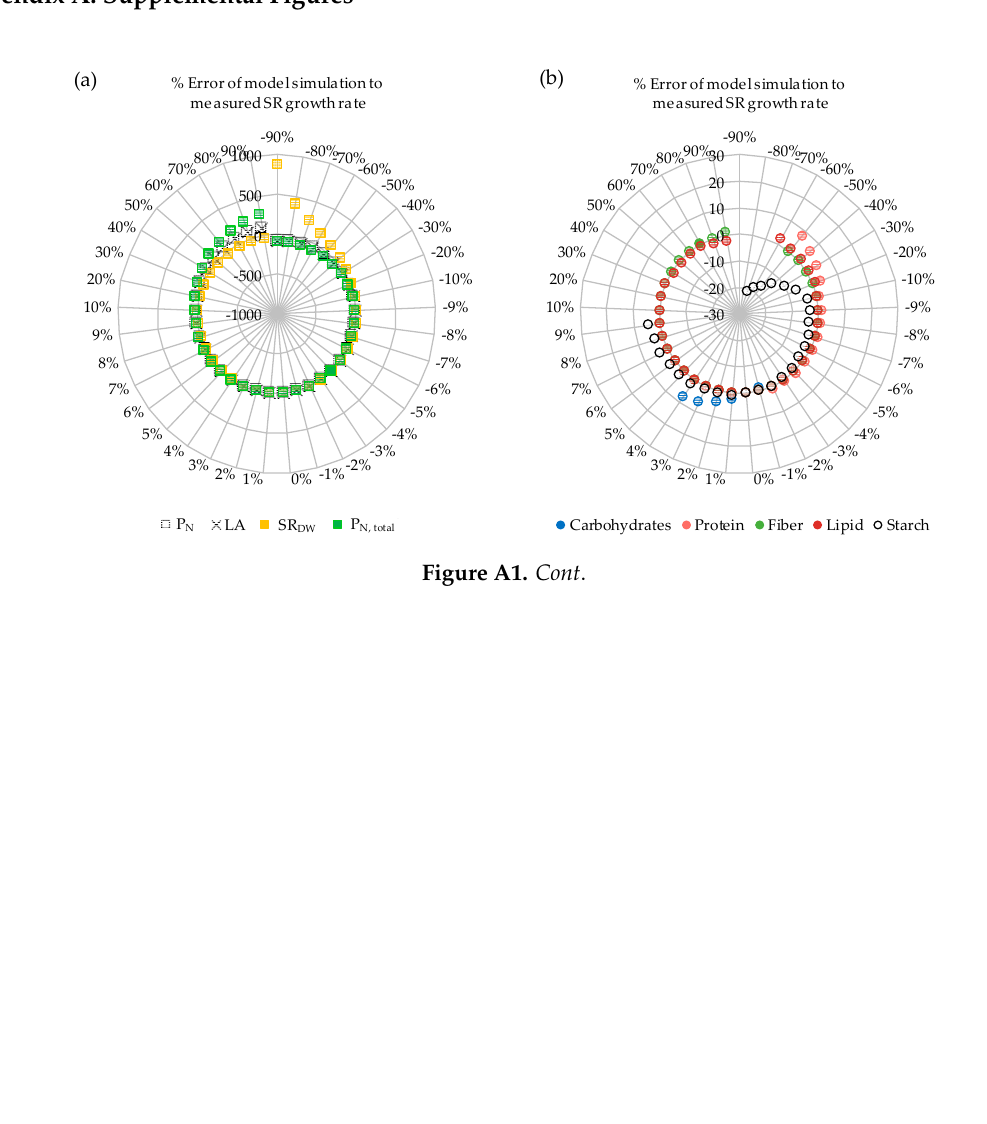
Figure A1. Sensitivity analysis of ( a ) variations in sucrose uptake rate-related data and ( b ) variations of biomass function-related data to the predicted storage root growth rate of the rMeCBM-KU50 model. ( c ) The percentage changes of predicted growth rate with respect to the original data. Each radar graph, the radial axes is the error percentage of model simulation to measured storage root